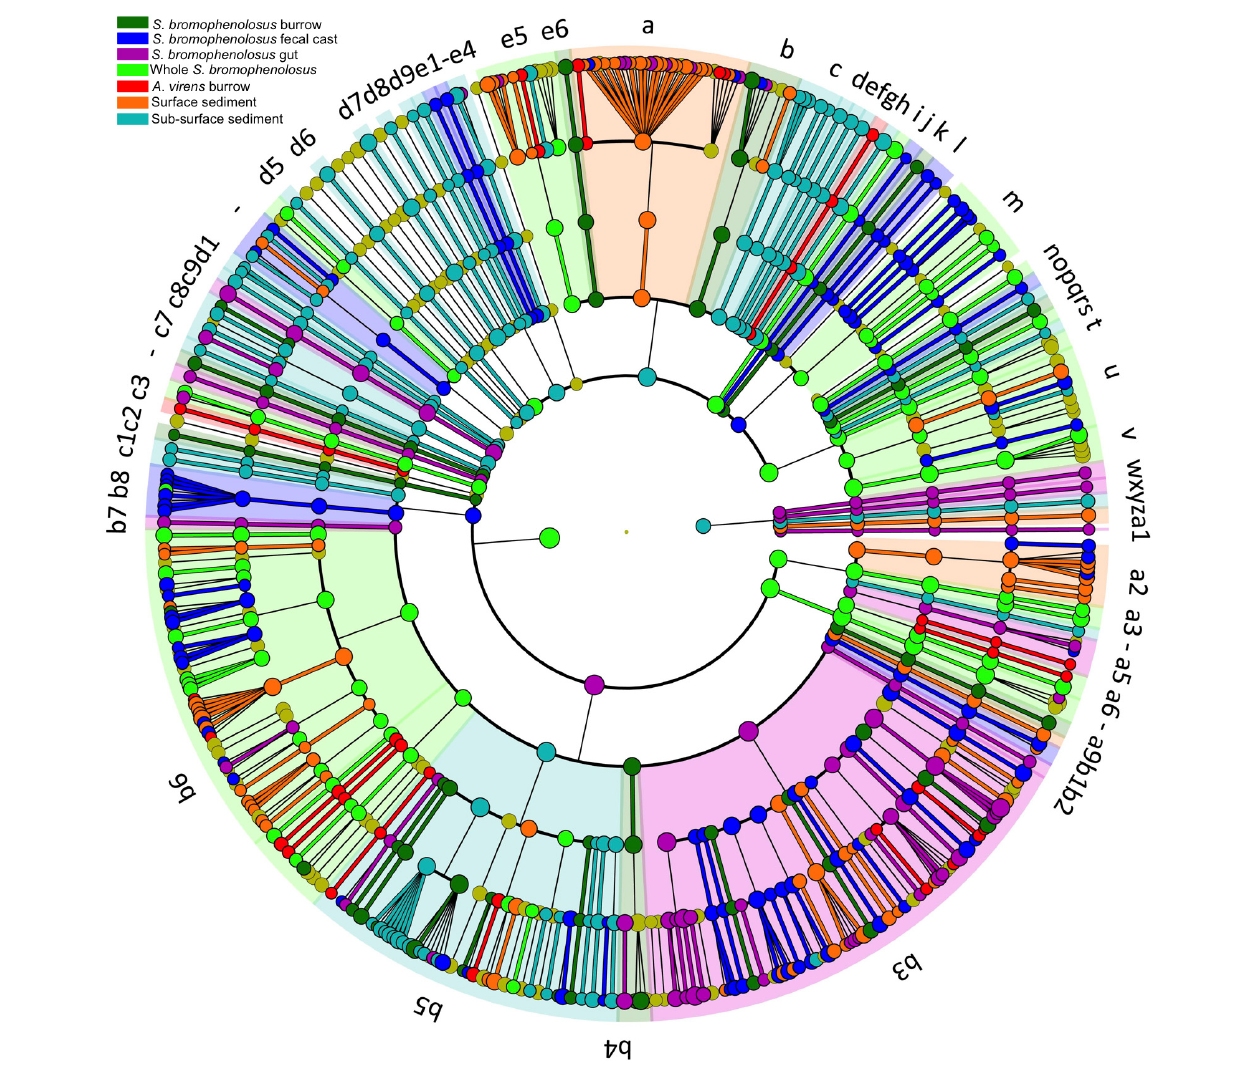
FIGURE 5 | LEfSe cladogram of animal and sediment microbial communities. Cladogram based on LEfSe analysis of the 1000 most abundant OTUs in the data set, showing the phylogenetic distribution of lineages associated with various animal and sediment groups as indicated by the source color key for lineages with LDA values ≥ 3.5. Circle diameters are proportional to OTU abundance with phylogenetic levels from domain to family from outside to inside. Key to discriminant lineages a, Flavobacteriia; b, Cytophagia; c, Bacteroidia; d, Bacteroidetes_vadinHA17; e, Bacteroidetes_unclassified; f, Bacteroidetes_VC2_1_Bac22; g, Bacteroidetes_Incertae_Sedis; h, Bacteroidetes_BD2_2; i, Bacteria_unclassified; j, Atribacteria; k, Aminicenantes; l, Thermoleophilia; m, Actinobacteria; n, Subgroup_6; o, Subgroup_26; p, Subgroup_22; q, Subgroup_21; r, Subgroup_2; s, Subgroup_18; t, Solibacteres; u, Holophagae; v, Acidobacteria; w, Lokiarchaeota; x, Thermoplasmata; y, Bathyarchaeota; z, Archaea_unclassified; a1, Ancient_Archaeal_Group_AAG; a2, Verrucomicrobiae; a3, Spartobacteria; a4, R76_B128; a5, Opitutae; a6, OPB35_soil_group; a7, Spirochaetes; a8, Zetaproteobacteria; a9, Proteobacteria_unclassified; b1, Proteobacteria_Incertae_Sedis;